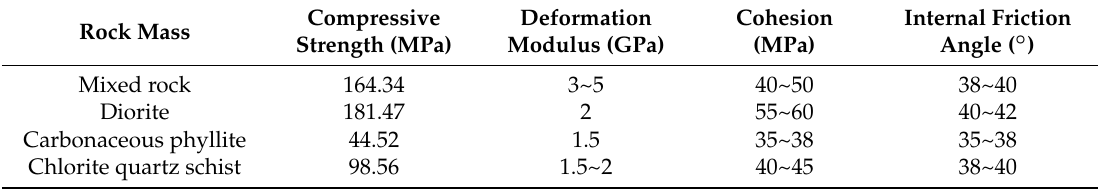
Figure 2. Overview of the study area. Shaded region represents the eastern final slope investigated in this study (Xu et al. 2016). Table 1. Mechanical parameters of the major rock masses found in the Yanqianshan iron mine.